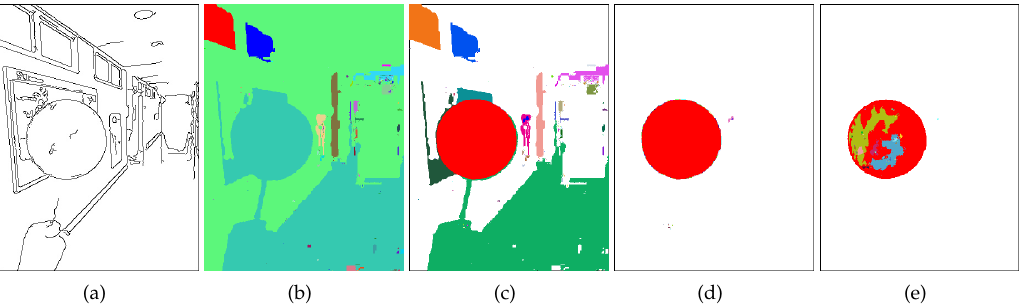
Figure 4. Edge pixels and connected components. ( a ) Edge image of Figure 3a. ( b ) Connected regions ( 1 ) S ( 1 ) detected in S , differently color-coded. ( c ) Connected regions detected in S m and d ( 3 ) S ( 3 ) ( d ) Connected regions detected in S . ( e ) Connected regions detected in S m and d